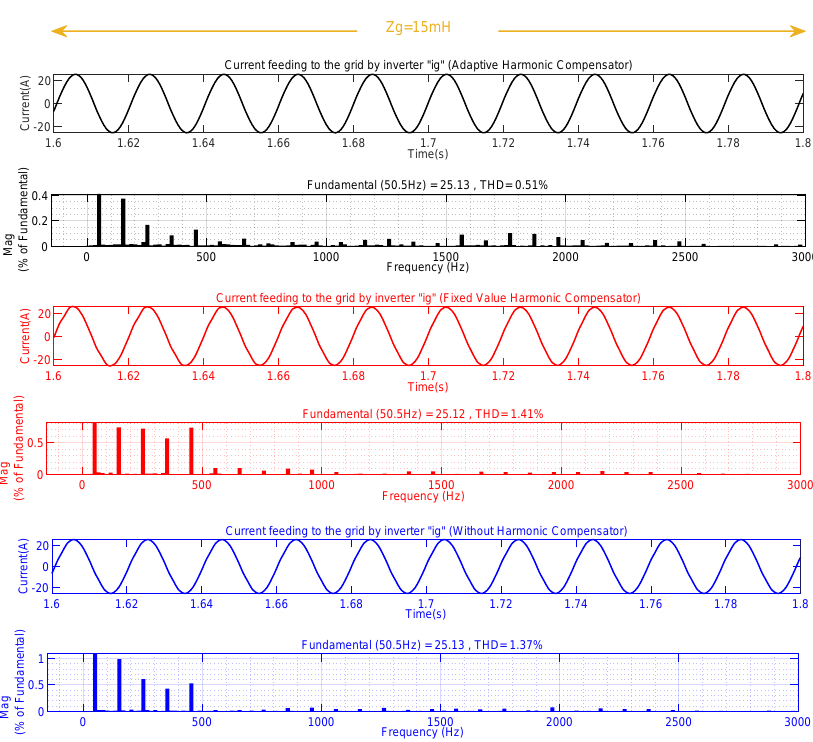
Figure 18. Results of proposed adaptive harmonic compensator, fixed value harmonic compensator and without harmonic compensator when grid frequency is 50.5 Hz.